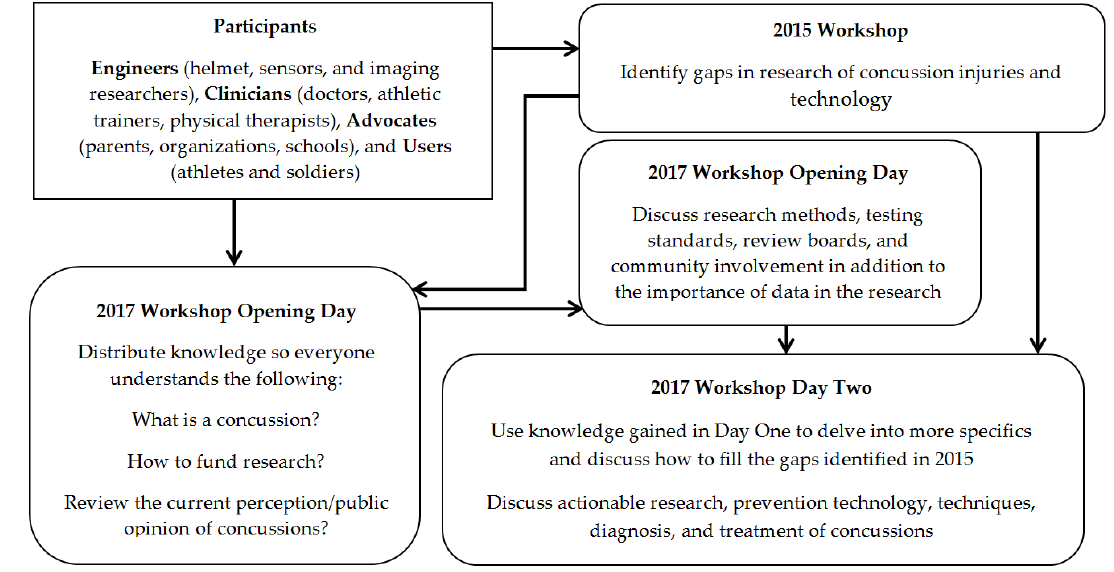
Figure 1. Flow Chart Displaying the Structure of the